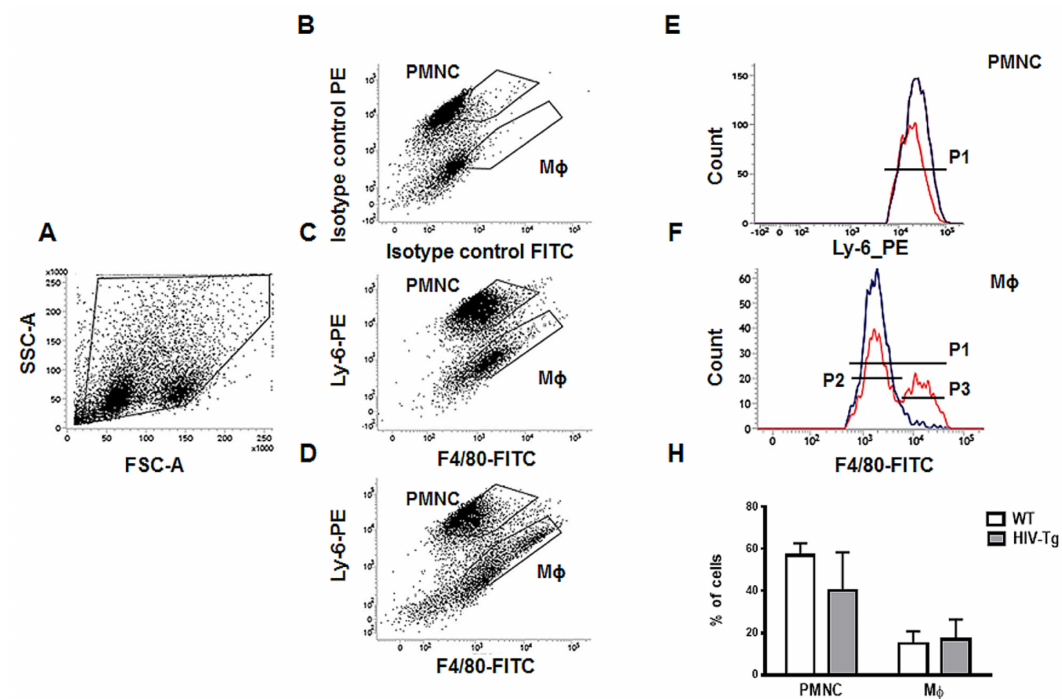
Figure 2. Similar levels of peritoneal neutrophils and macrophages in HIV-Tg and WT mice 24 h after LPS injection ( A ) Forward scatter versus side scatter (FCS vs. SSC) plot represents all peritoneal cell populations and gating strategy. ( B – D ) Flow cytometry analysis of peritoneal lavage shows neutrophil (PMNC) and macrophage (M φ ) subsets in isotype control (panel B), WT mice (panel C) and HIV-Tg mice (panel D). ( E , F ) representative flow cytometry data for PMNC ( E ) and M φ s ( F ) for WT (blue color) and HIV-Tg (red color) mice. ( H ) Quantification of flow cytometry data for peritoneal PMNC and M φ for P1 gate ( n = 5). P2 is a gate for M φ with low level F4 / 80, P3 is a gate for M φ with high level of F4 / 80. Results are shown as percent of cell population. Mean and standard error are